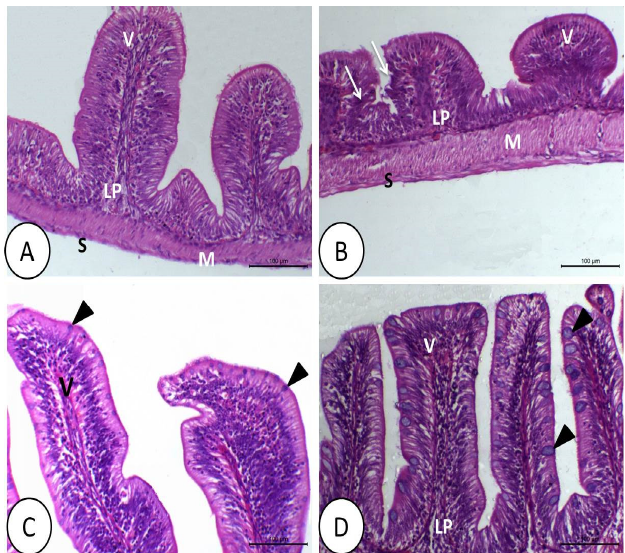
Figure 3. Histology of intestine of Nile tilapia in the control ( A ), deltamethrin (DMT) ( B ), synbiotic ( C ), and DMT with synbiotic ( D ) groups. In ( A ), the intestine shows normal histological structures, including the intestinal villi (V), lamina propria sub mucosa (LP), tunica muscularis (M), and tunica serosa (S). The toxic effect of deltamethrin ( B ) decreases the number of intestinal villi with degener- ation of the epithelial lining (white arrow) and leukocytic infiltration. In ( C , D ), the intestine has a normal appearance like that in the control group. The intestinal villi increase in number, height, and width with prominent goblet cells (black arrowhead) and without a toxic effect of deltamethrin in group ( D ). H&E staining; bar = 100 μ m. Animals 2021 , 11 , x